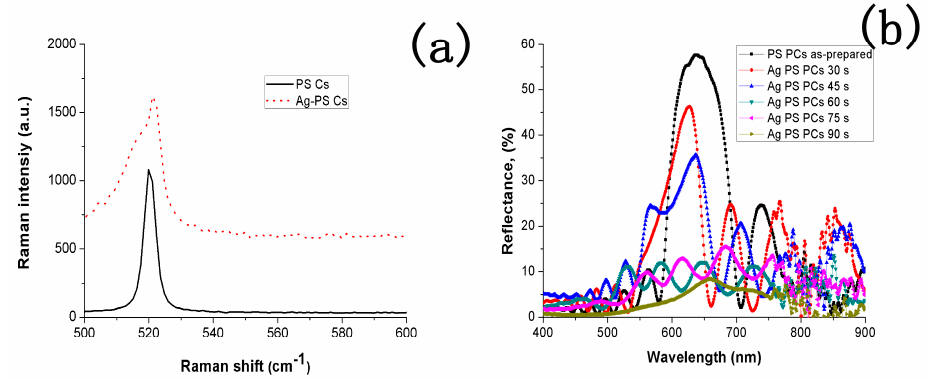
Figure 2. ( a ) Raman pattern and ( b ) reflectance spectra of AgNP-decorated PS PC samples with different Ag deposition times. The image shows the behavior of the reflectance spectrum of the PS PC samples with and without Ag nanoparticles.